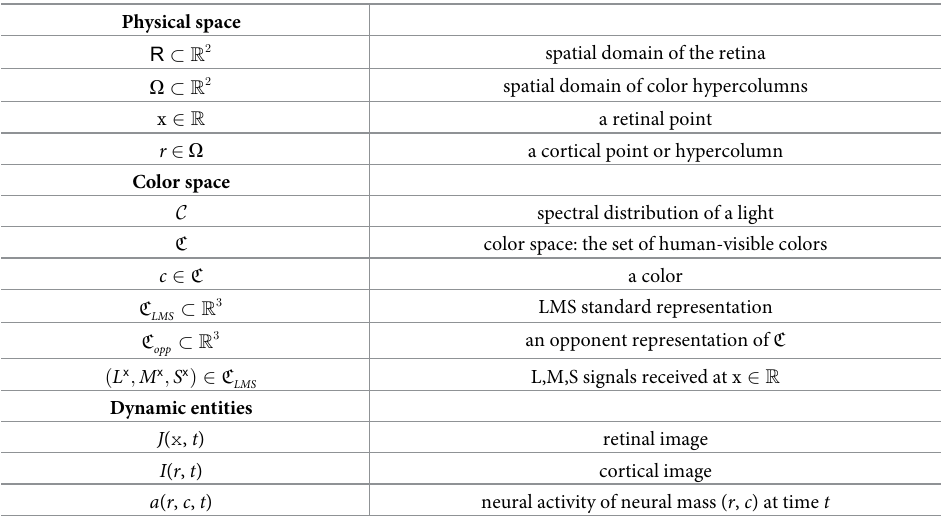
Table 1. Mathematical